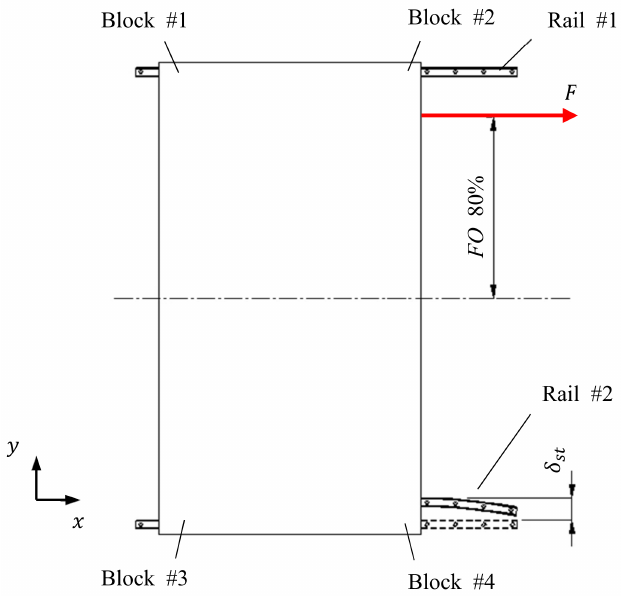
Figure 15. Parallelism error between LM